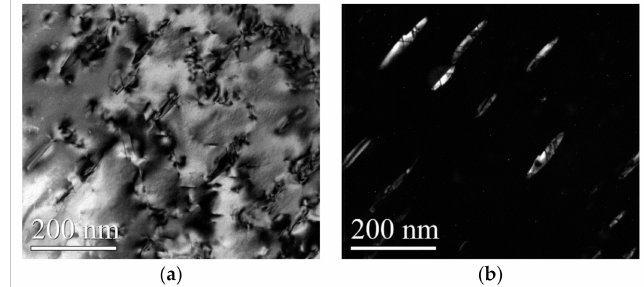
Figure 11. A comparison of the light field phase and the dark field phase of the δ phase shocked by LSP at 200 ◦ C. ( a ) Bright field phase, ( b ) Dark field